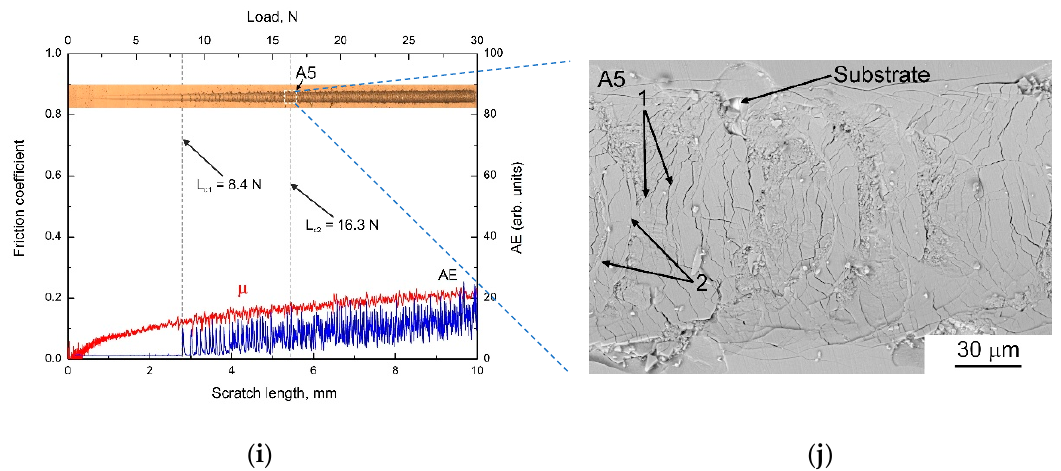
Figure 2. Scratch tracks, friction coefficients ( µ ), acoustic emission signals (AE) and critical loads (left panel), and corre- sponding SEM micrographs of specific areas of the scratch tracks denoted as A1–A5 (right panel) of ( a,b ) Ti 0.45 Al 0.55 N; ( c,d ) ML1; ( e,f ) ML2; ( g,h ) ML3; and ( i,j ) Ti 0.43 Al 0.45 Ta 0.12 N coatings, respectively. Arrows in the right panel indicate different types of cracks: 1—tensile cracks; 2—conformal cracks; 3—edge cracks.